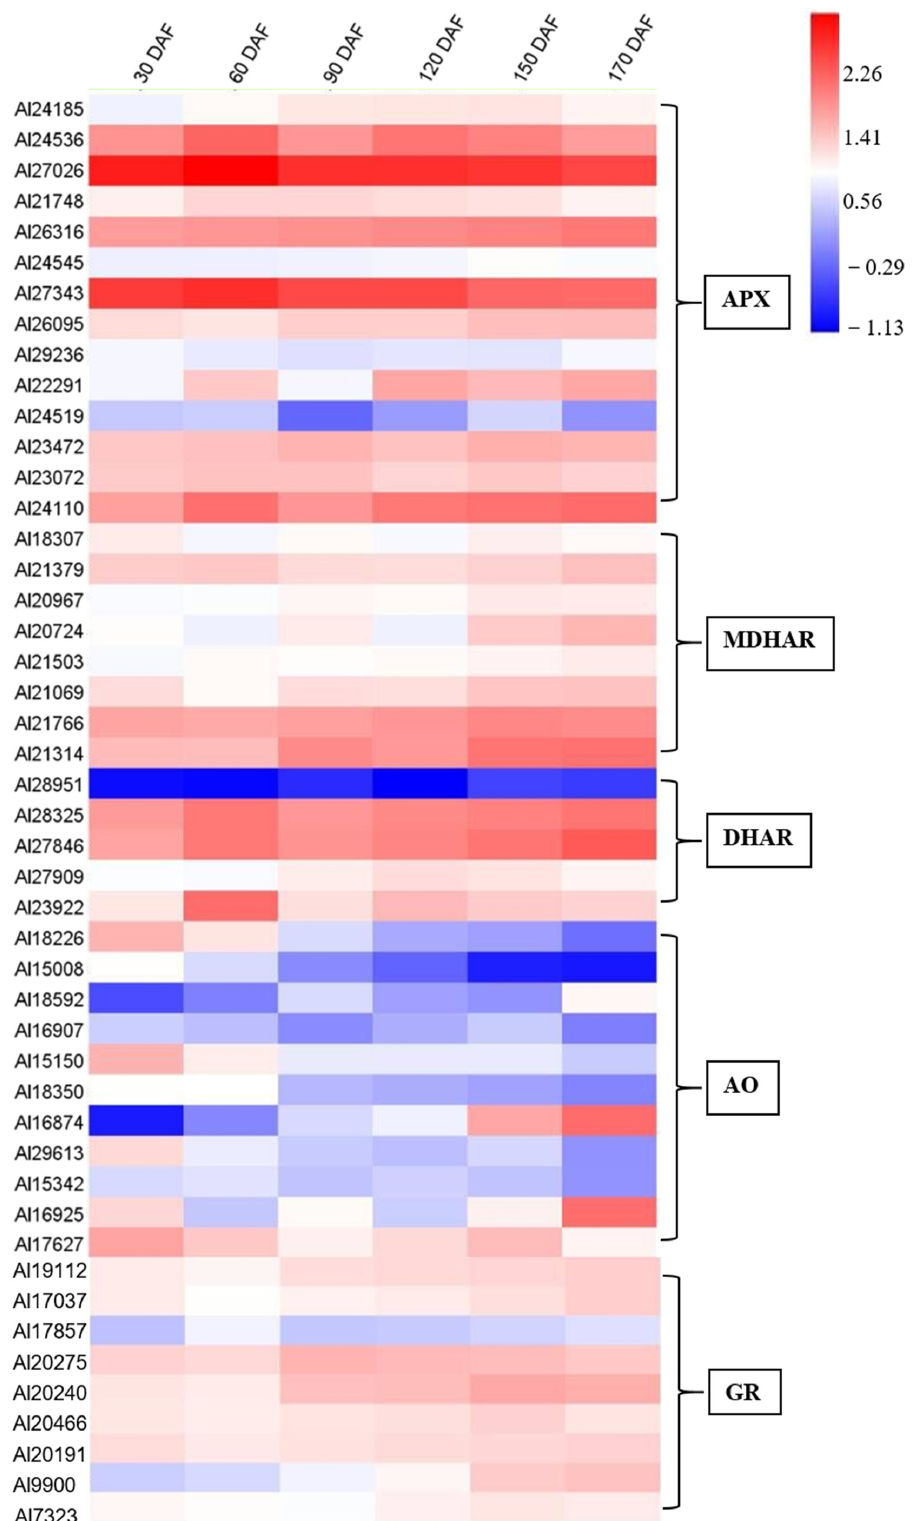
Figure 5. Heat map depicting the expression profiles of AsA recycling-related genes during fruit development and ripening of A. latifolia . The mean values from transcriptome data of the triplicates were used for heat map construction. The expression level was represented by a color scale located at the top right